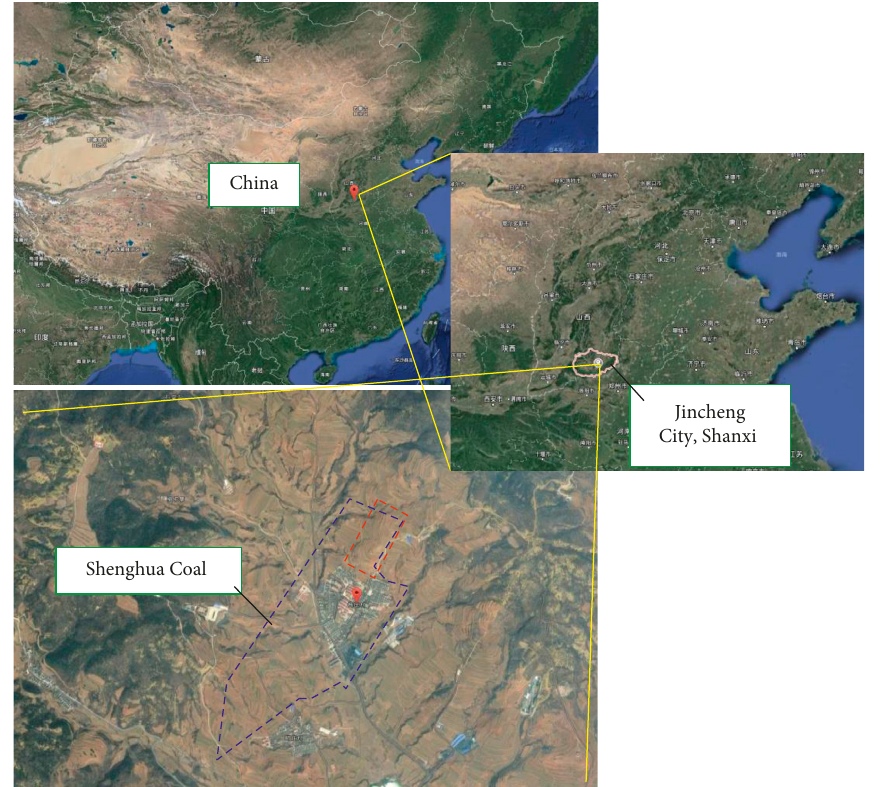
Figure 2: Location of the test